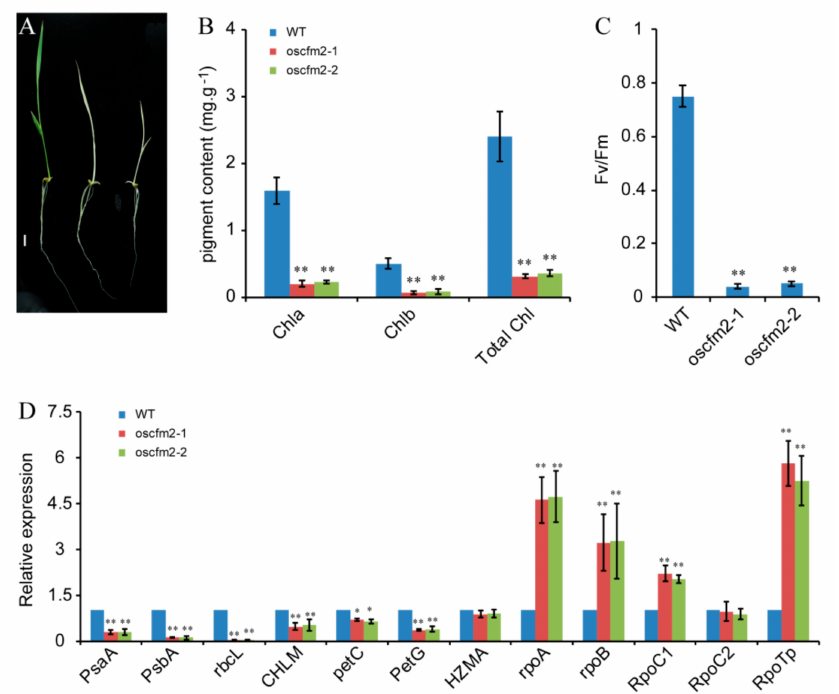
Figure 6. Mutation of OsCFM2 causes an albino phenotype in rice leaves. ( A ) Phenotypes of the WT (left) and oscfm2-1 (middle) and oscfm2-2 mutants (right) at the seedling stage. Scale bar = 0.5 cm. ( B ) Chlorophyll contents of WT and oscfm2-1 and oscfm2-2 mutants at the seeding stage. ( C ) The Fv / Fm value of the WT and oscfm2-1 and oscfm2-2 mutants at the seeding stage. ( D ) qRT-PCR analysis of genes related to chloroplast synthesis and photosynthesis in the WT and oscfm2-1 and oscfm2-2 mutants. Values represent the mean ± SD (n = 3). ** p < 0.01 by Student’s